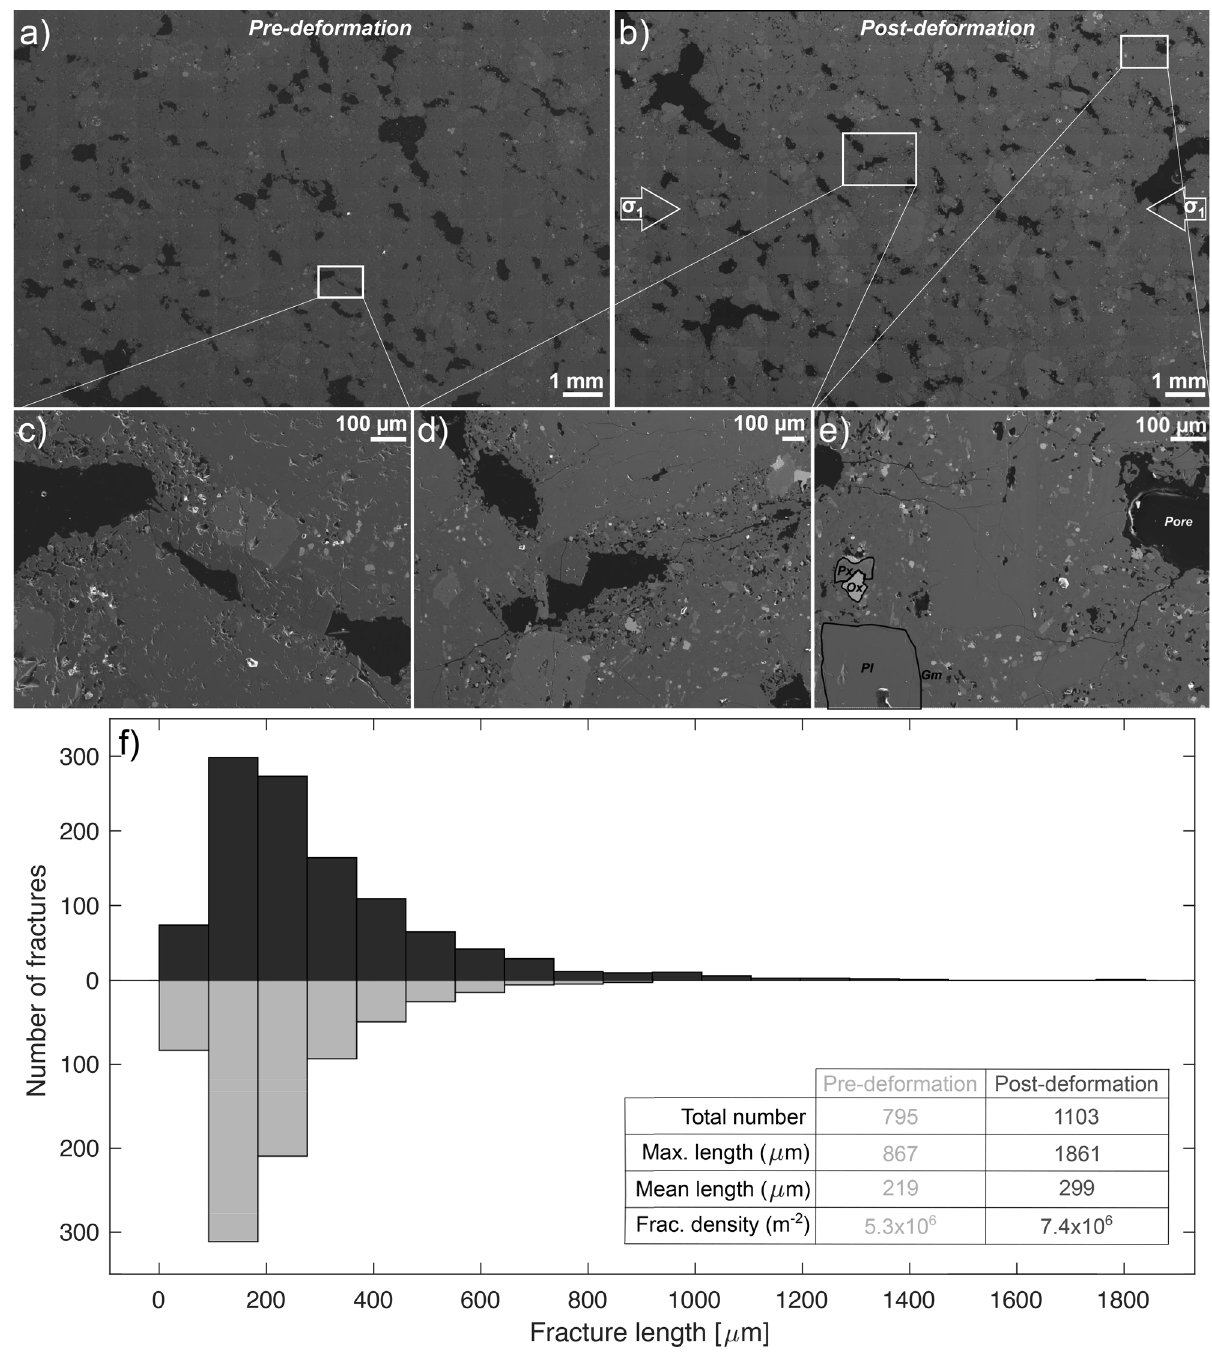
Figure 1. Microstructural fabrics of pre- and post-deformation materials. Backscatter electron scan of ( a ) intact material (pre-deformation) and ( b ) deformed material (post-deformation; with creep at 65% of average uniaxial compressive strength (UCS), ± 5% amplitude stress oscillation) showing phenocrysts of pyroxene (Px; light grey) and plagioclase (Pl) set in a glassy groundmass (Glm; both dark grey) with microlites of plagioclase, pyroxene and oxides (Ox; white) and pores (black). ( c ) Zoomed-in section of the intact material (from inset in ( a )) with very low prevalence of microfractures. ( d,e ) Zoomed-in sections of the deformed material (from insets in ( b )) showing that micro-fractures extend from the pores, sub-parallel to the applied principal stress (σ 1 , indicated in ( b )) and traverse the groundmass and phenocrysts as a result of the experiment. ( f ) Fracture length distribution for the intact (light grey) and deformed samples (dark grey) showing that the deformed material hosts a slightly higher number of fractures and thus fracture density. Fractures in the deformed material also attain greater lengths than the pre-deformed